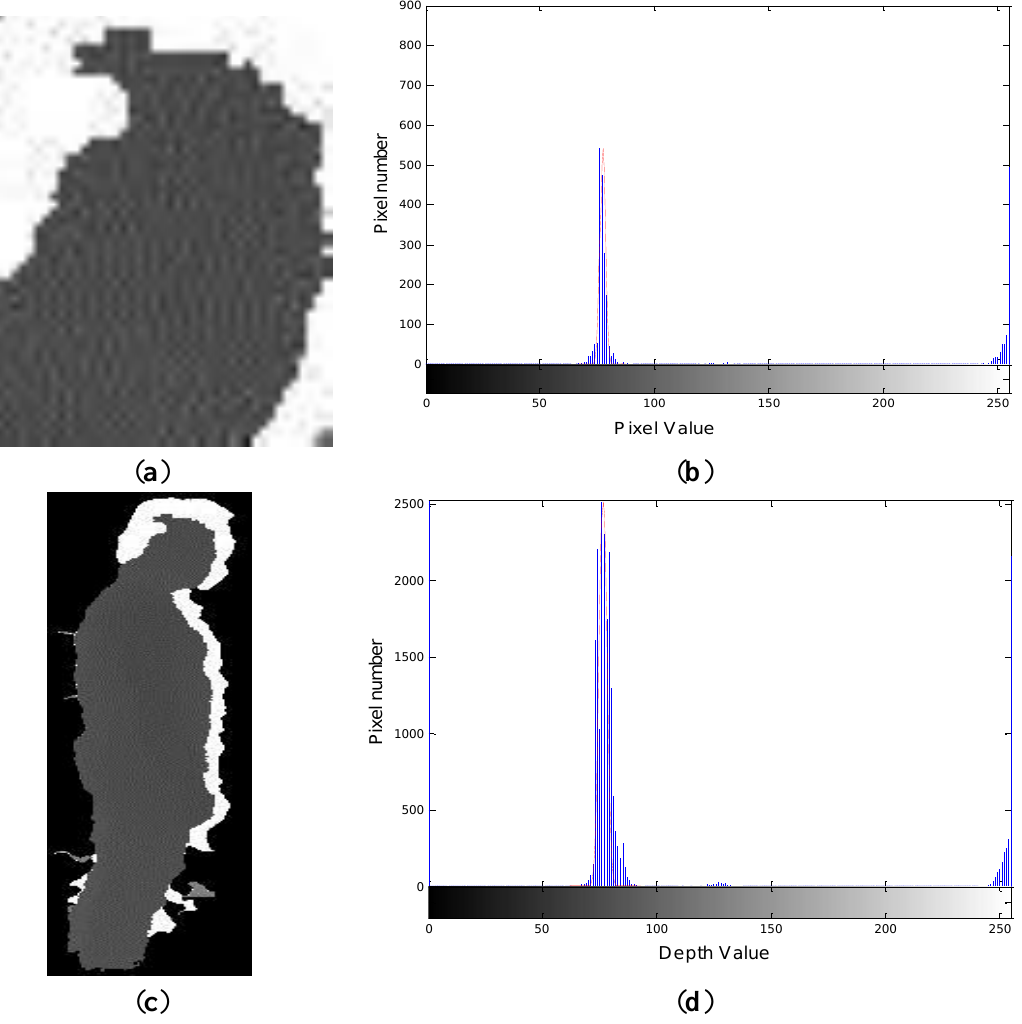
Figure 6. Histogram of head and human in depth images. ( a ) Head depth image; ( b ) histogram of head in depth image; ( c ) human subject depth image; ( d ) histogram of human subject depth